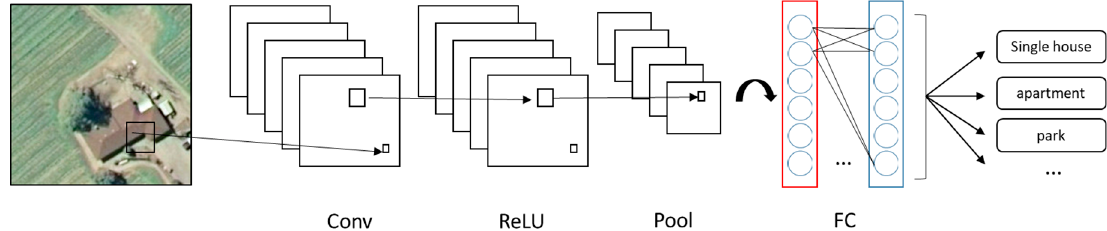
Figure 1. An example structure of convolutional neural networks (CNN).